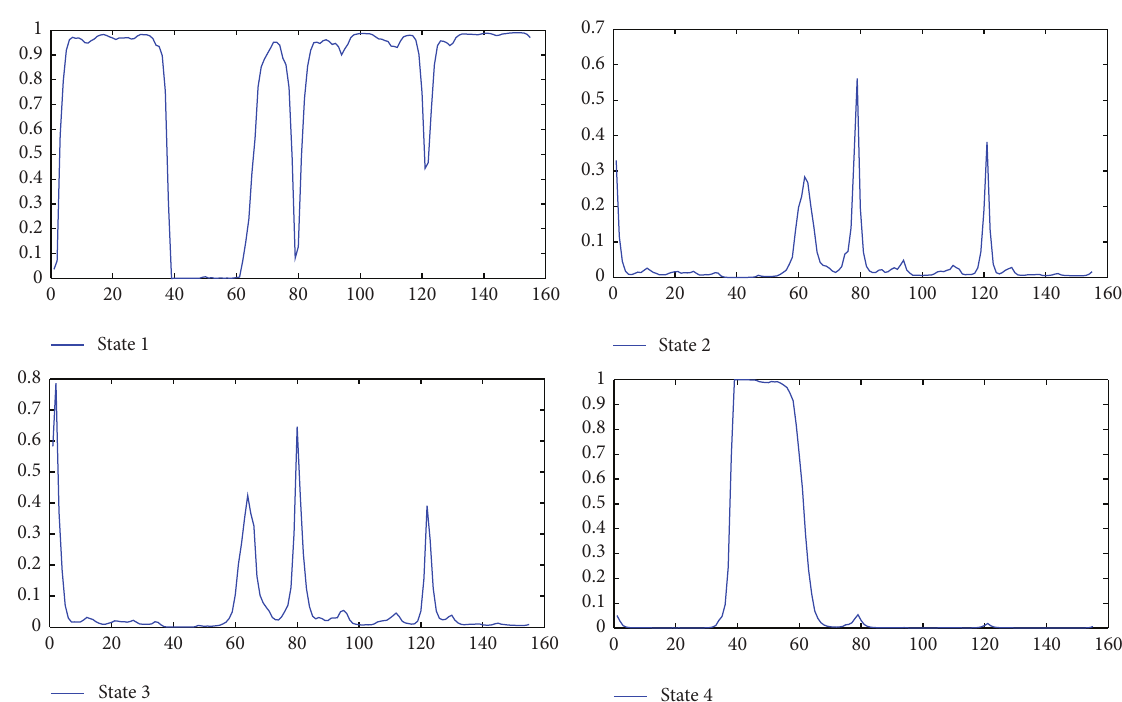
Figure 12: Smoothed probabilities P (𝑆 𝑡 = 𝑘 | 𝜓 𝑇 ) for 𝑡 ∈ Λ , 𝑘 ∈ {1,2,3,4}